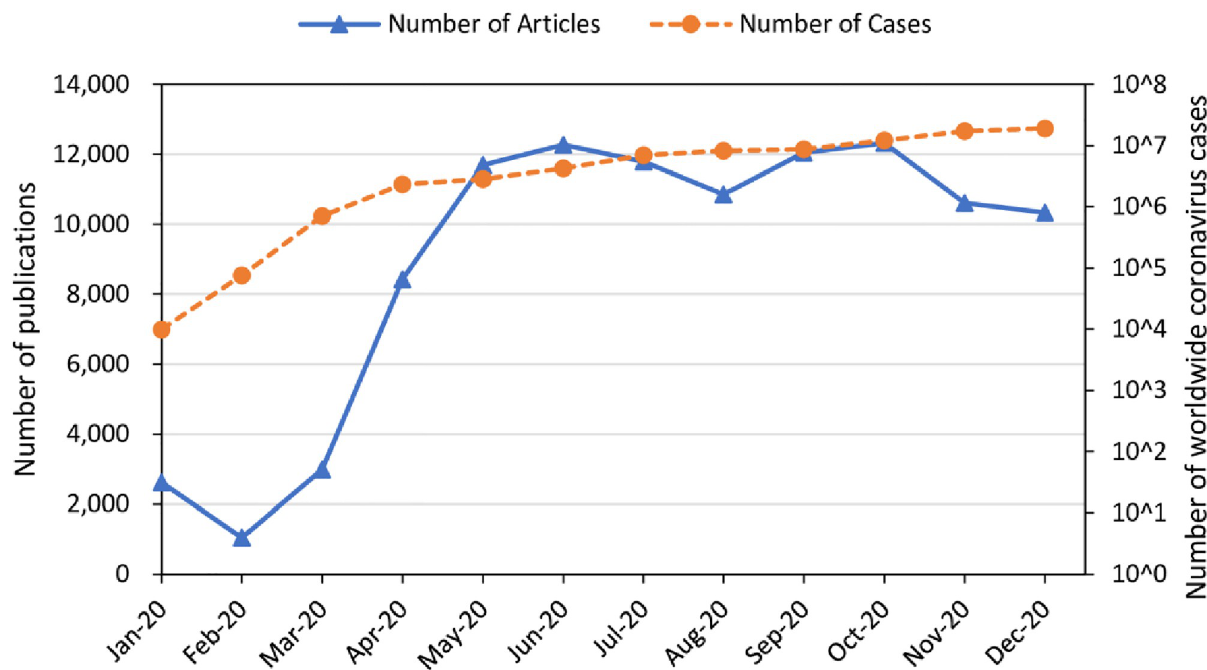
Fig 1. Number of publications and worldwide COVID-19 cases per month in 2020. Data on publications and cases are collected from CORD-19 and WHO (https://covid19.who.int/).